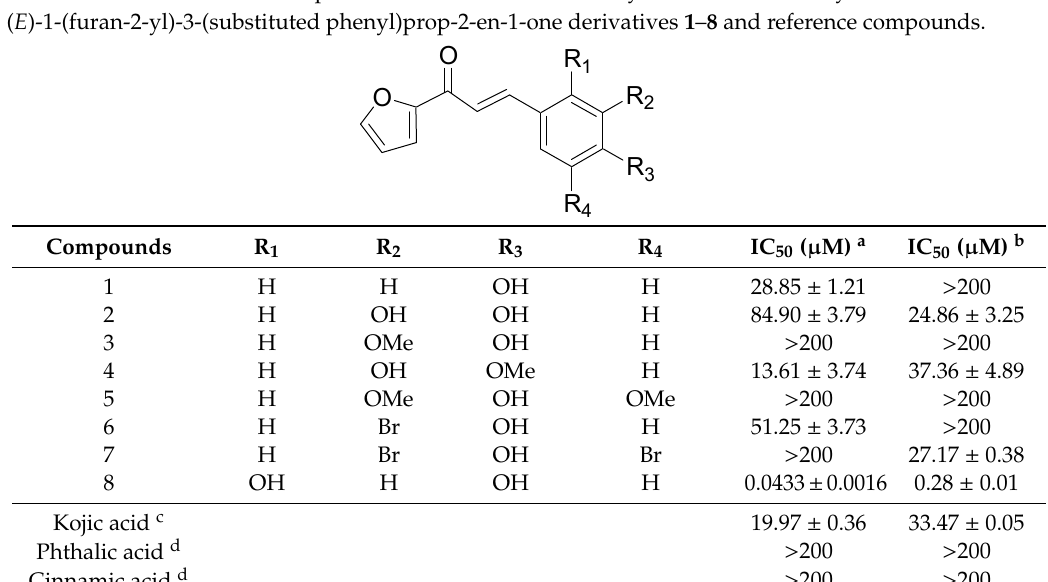
Table 1. Substitution patterns and mushroom tyrosinase inhibitory activities of ( E )-1-(furan-2-yl)-3-(substituted phenyl)prop-2-en-1-one derivatives 1 – 8 and reference compounds.